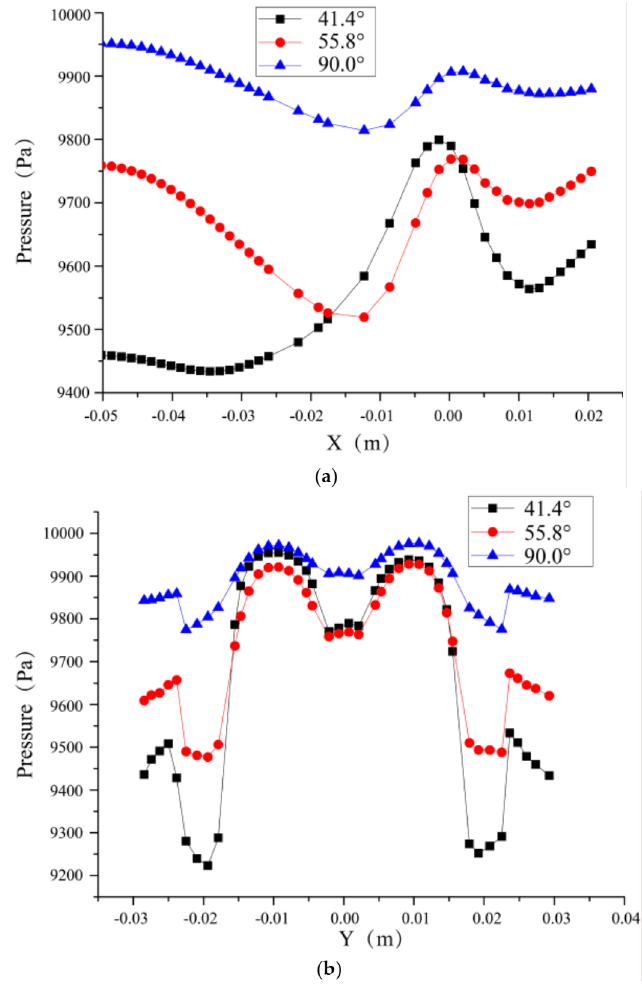
Figure 14. ( a ) The pressure distribution along the length direction (X) of the valve. ( b ) The pressure distribution along the width direction (Y) of the